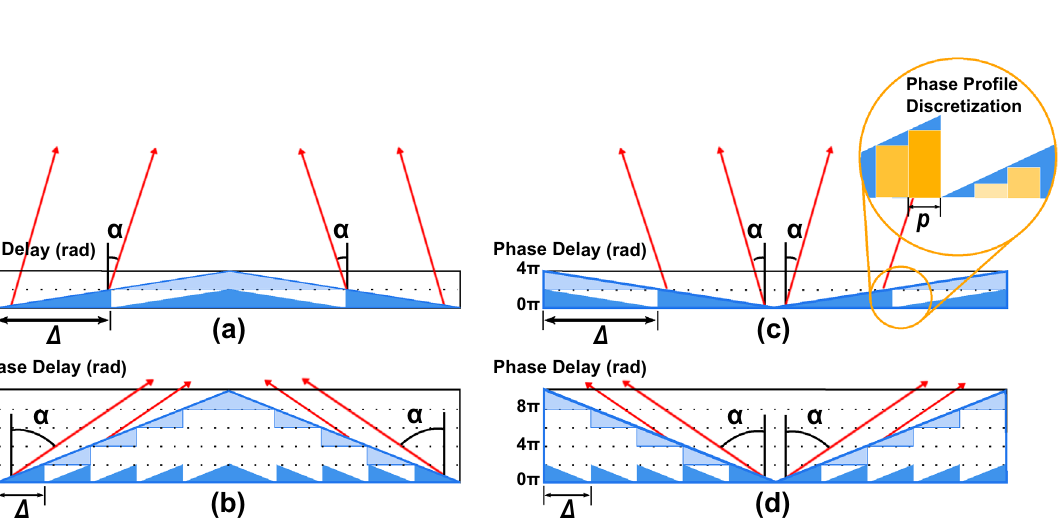
Figure 1. On the left, representation of two convergent blazed axicons wrapped over a 2π range. On the right, representations of divergent blazed axicons. The two different rows show two different grating pitches (Δ). The insert shows the discrete pixel distribution and pixel pitch